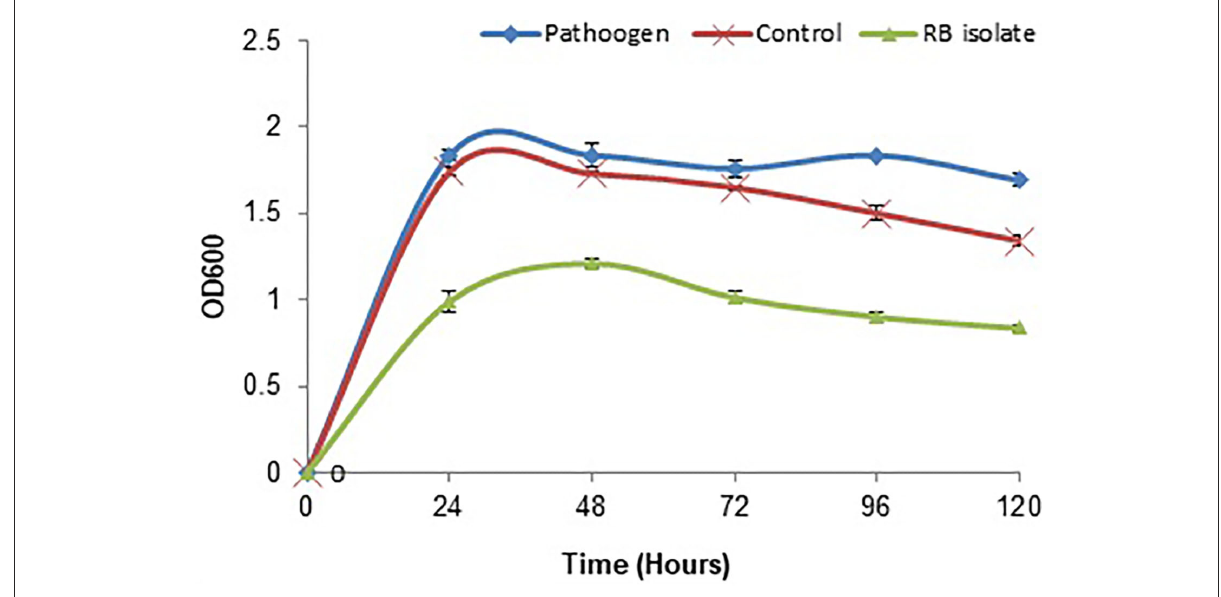
FIGURE8 Growth inhibition of L. amnigena RCE by crude extract of bacteria. Values represent the mean of three replications. Bars indicate the standard error of the mean.